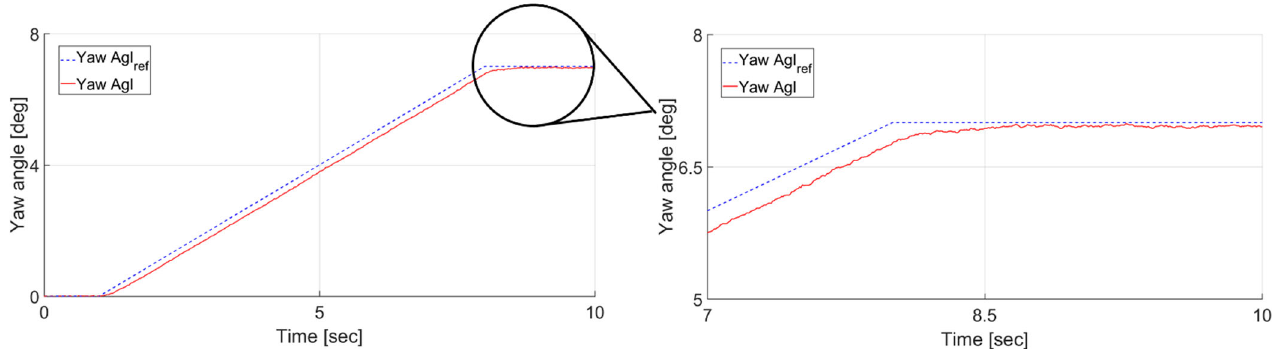
Figure 10. Yaw direction bending